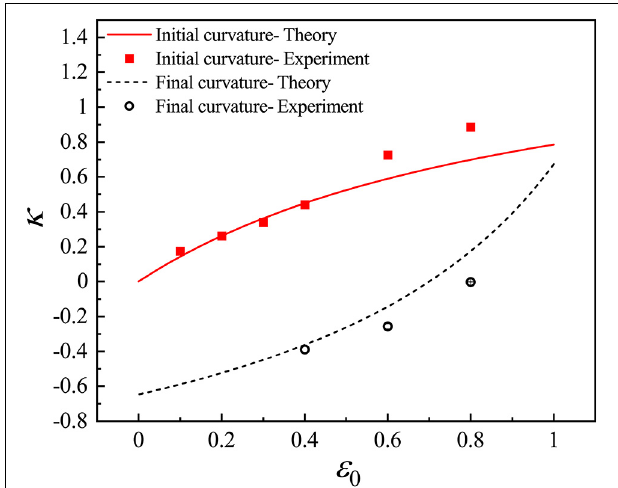
FIGURE 4 | The initial and final average curvatures of the slender pre-strained bilayer structure. Symbols are experimental data and lines are predictions of Equation (1) and (2). The solid lines and filled dots are the initial average curvatures and the dash lines and hollow dots are the final average